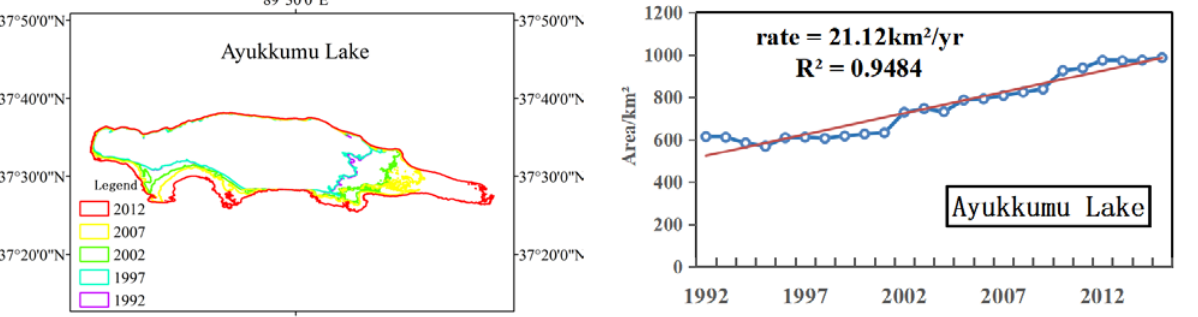
Figure 7. Annual area variation of several typical lakes (take the Ayukkumu Lake as an example) on TP from 1992 to 2015, left for the extraction